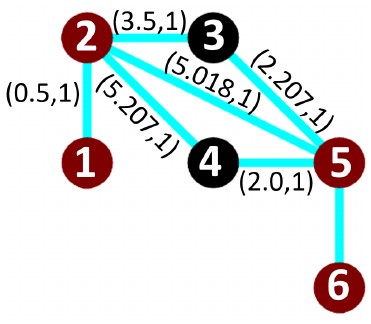
Figure 10. Turning node edges. Table 3. Possible time cost for edge(5,6).